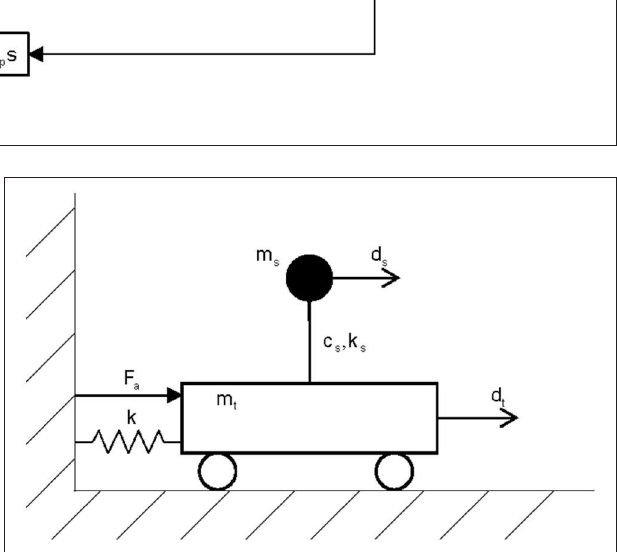
FIGURE 3 | Schematic of single-degree-of-freedom shake-table